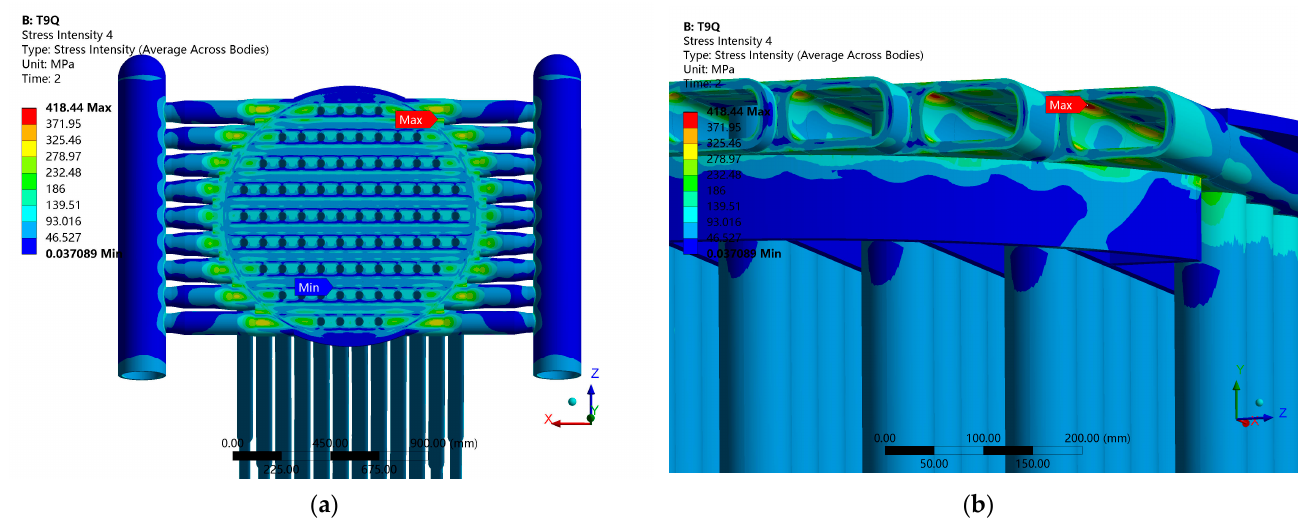
Figure 7. ( a ) Stress intensity distribution and ( b ) maximum stress on the upper flat-round tubesheet under load case 2 with 9 mm pretension of the tubes.